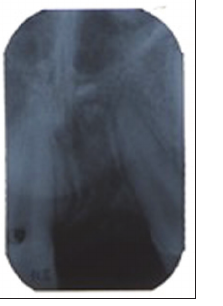
Figure 5a. Pustule in the upper left permanent central incisor region which presented intra-orally by a non-draining parulis.